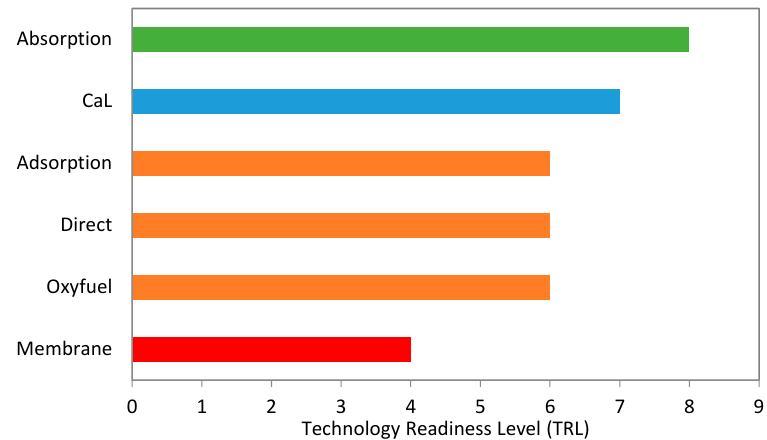
Figure 16. Current technology readiness level of CO 2 capture technologies in the cement sector (adapted from [83]).